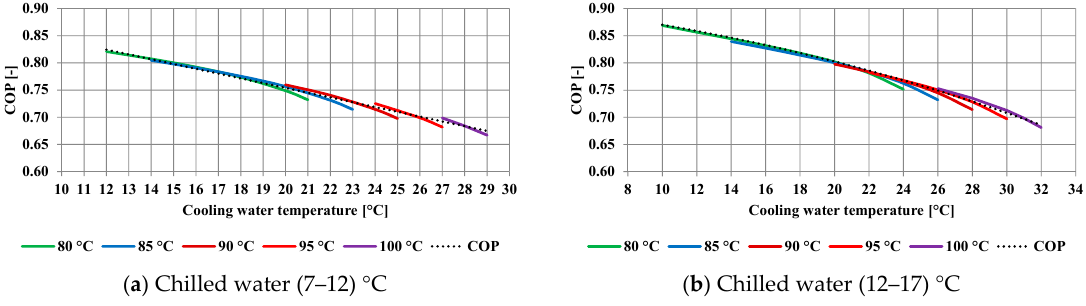
Figure 16. Variation of COP with the cooling water temperature and with hot water temperatures.